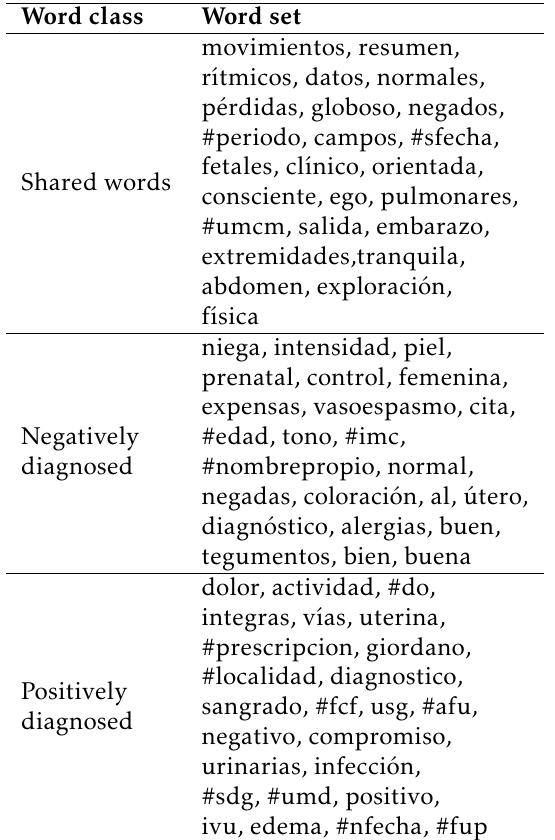
Table 2. UTI word sets